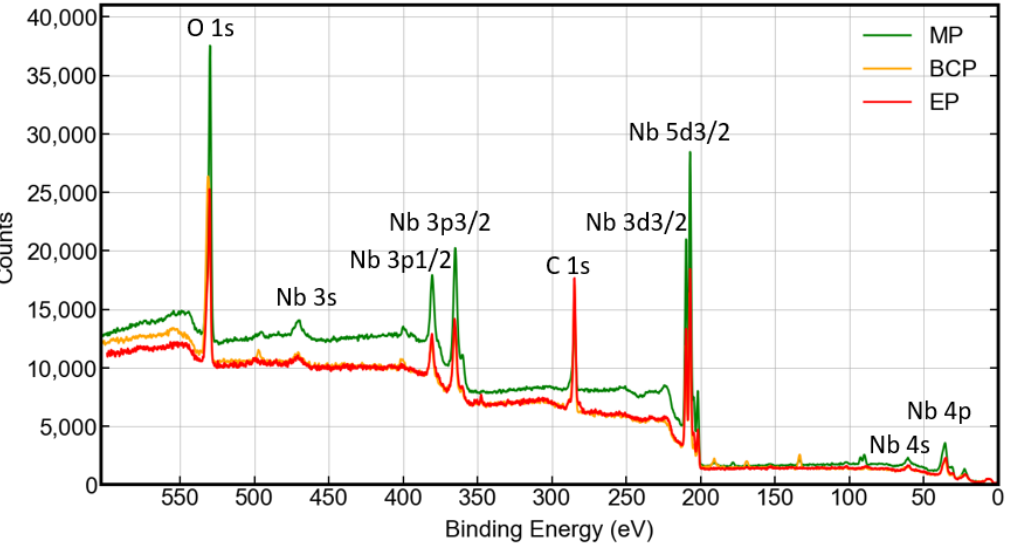
Figure 16. XPS survey spectra of Nb samples after MP, BCP, and EP treatment, calibrated with C 1s position at binding energy 284.8 eV.